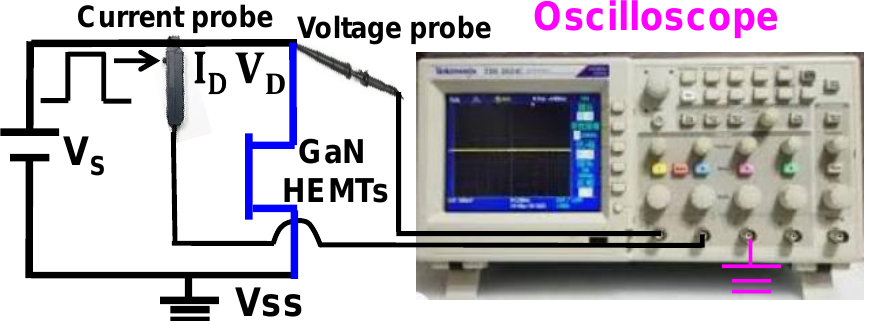
Figure 3. Setup for the PD observation of the GaN HEMTs during the breakdown voltage V bk meas- urement.